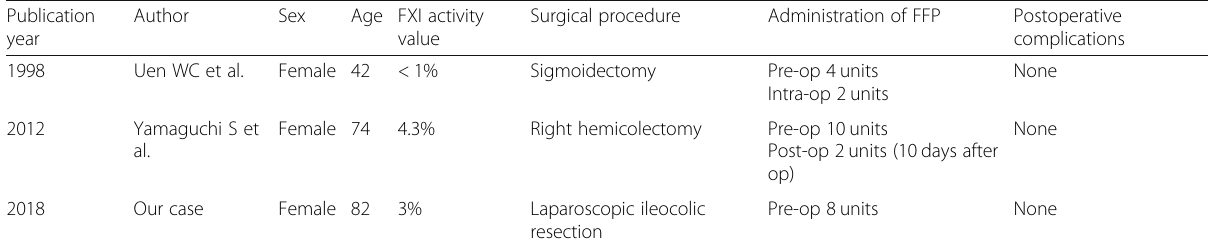
Table 1 Summary of the three reported cases of colorectal cancer surgery with factor XI